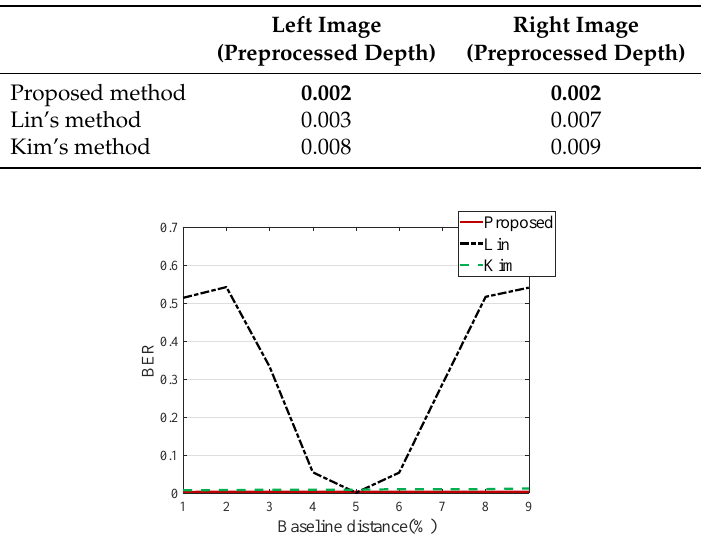
Figure 12. Average BER for baseline distance adjustment.